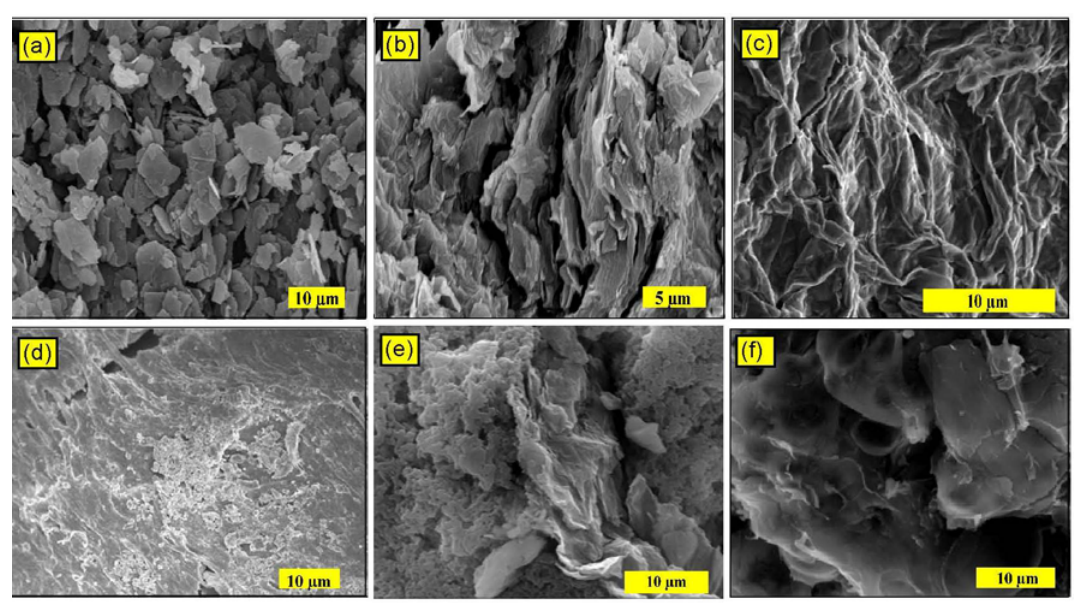
Figure 5. The SEM micrographs of ( a ) graphite; ( b ) GO; ( c ) RGO; ( d ) neat PMMA; ( e ) RGO-(PMMA) nanocomposites; and ( f ) R-(GO-PMMA) nanocomposites after reduction by